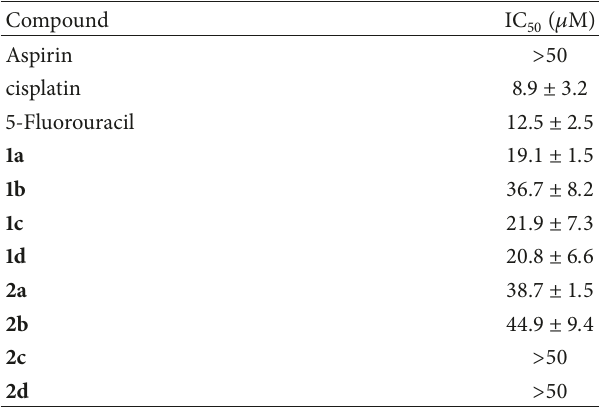
Table 1: IC 50 of 1a–d and 2a–d , aspirin, 5-fluorouracil, and cisplatin against NPC HK-1 cells